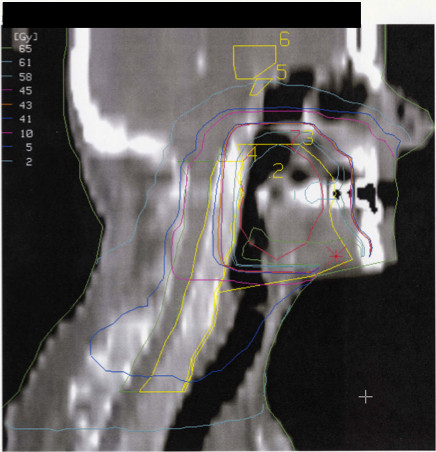
The sagittal view of the dose distribution of the external beam radiotherapy from patients with cancer of the tonsil. Volumes of interest and isodose lines are presented. Abbreviations: 2= Gross target volume (GTV), 3=Planning target Volume (PTV), 4=medulla, 5= pituitary, 6= hypothalamus.